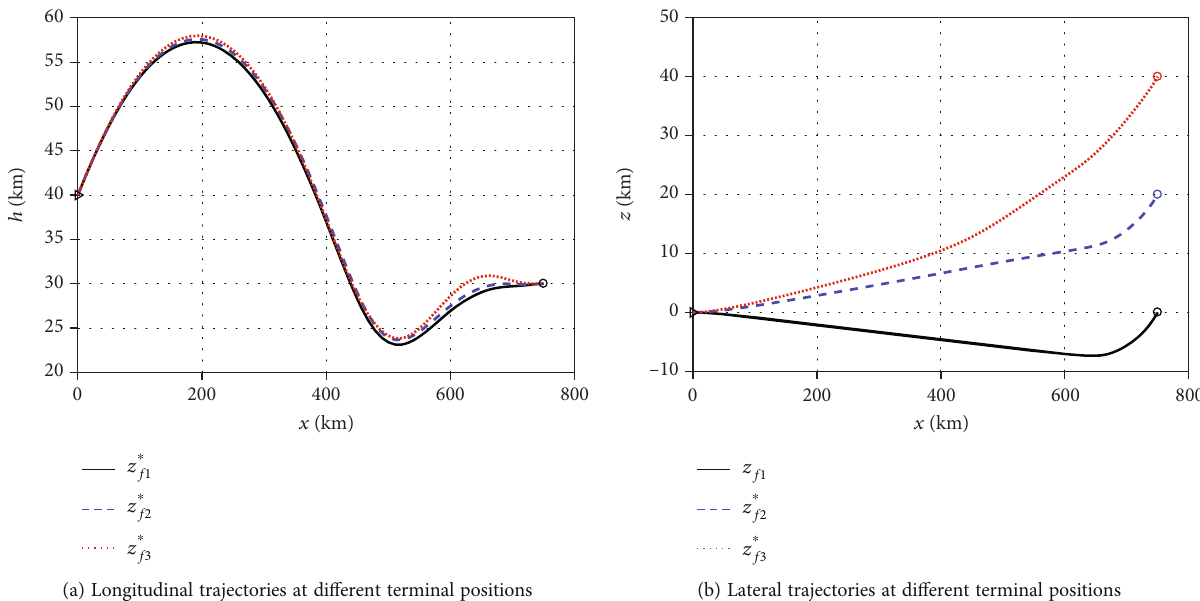
Figure 10: Trajectories at di ff erent terminal